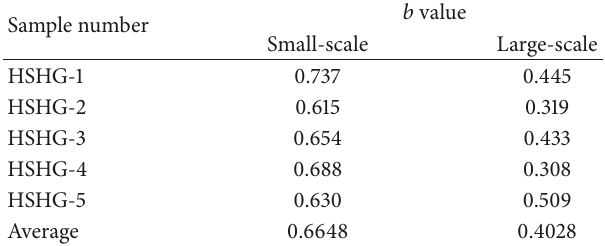
Table 1: 𝑏 value of small- and large-scale